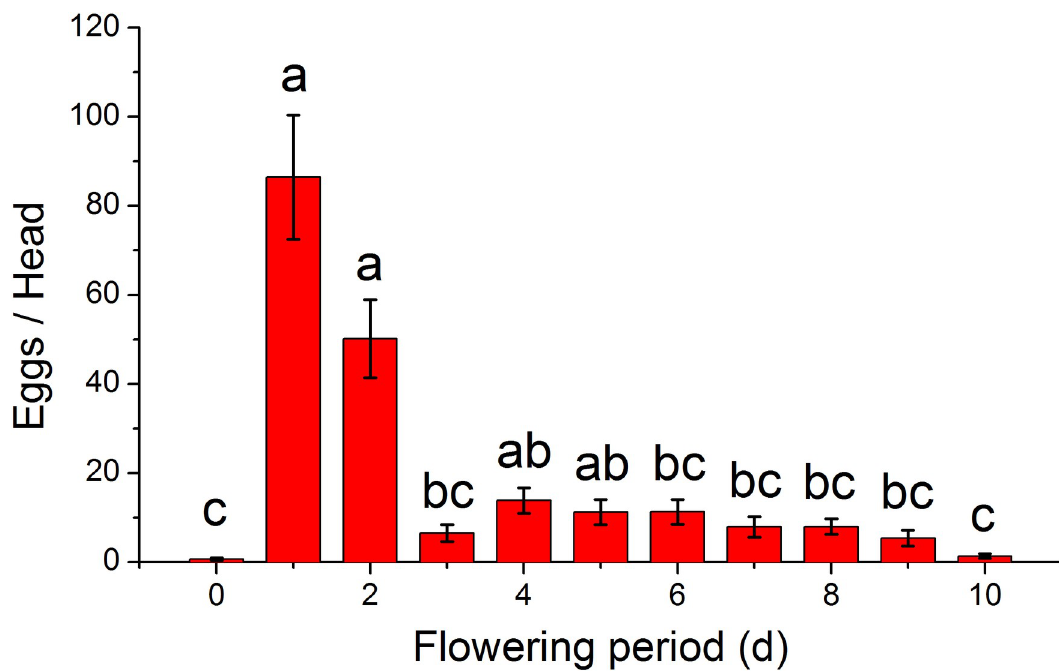
Fig 3. Daily oviposition of H . nebulellum on sunflower head across period of flowering. Day 0 indicates negative control, in which flower heads were bagged across the full testing period. Means ( ± SEM) sharing the same letter are not significantly different ( α = 0.05) analyzed by Kruskal-Wallis test. Sample size per group was